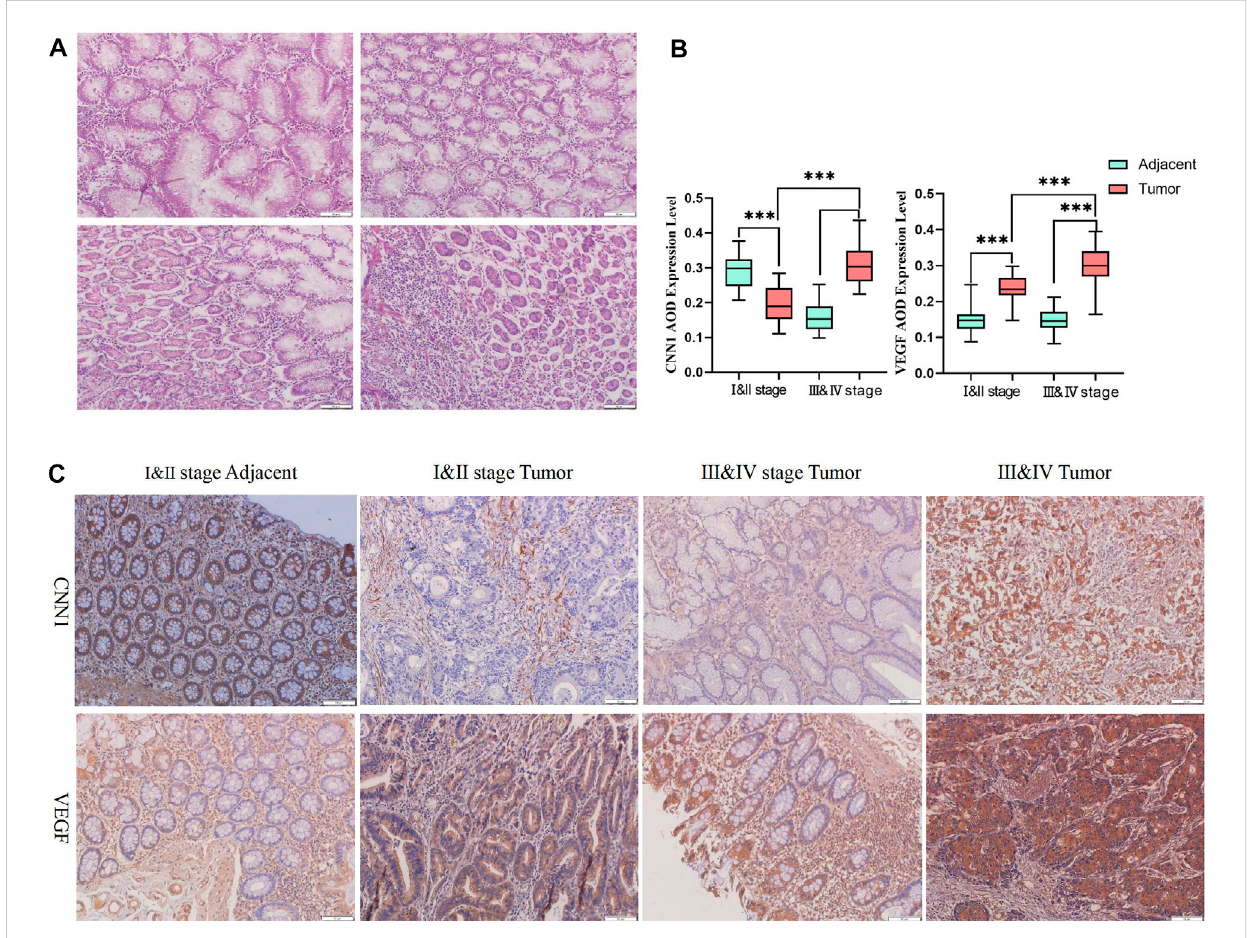
FIGURE 8 HE staining and immunohistochemistry results. (A) HE staining results in tumor and paraneoplastic tissues in GC. (B) Statistical results of immunohistochemical experiments (* p < 0.05, ** p < 0.01, and *** p < 0.001). (C) Immunohistochemical results of CNN1 and VEGF between tumor and paraneoplastic tissues in